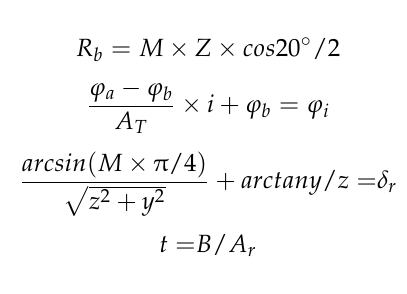
Figure 9. Relationship diagram between the 3D model and the mesh solid model.